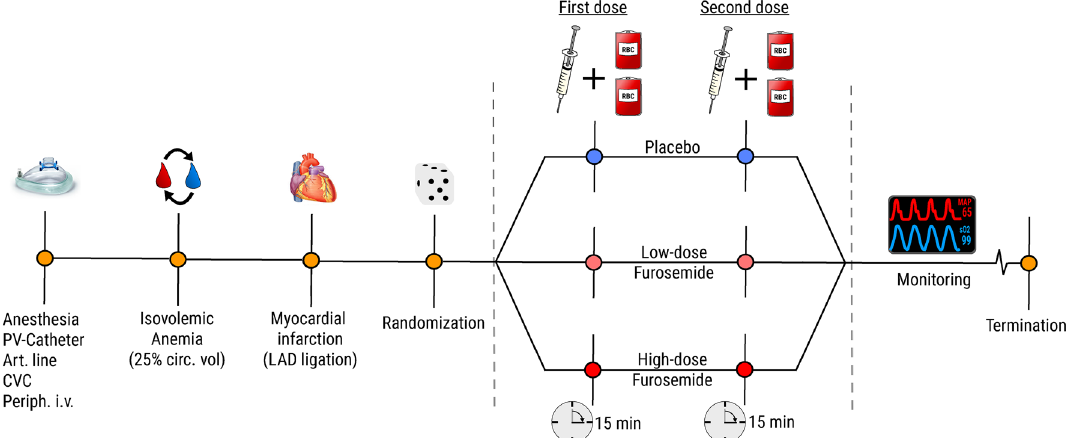
Figure 3. Experimental design. Rats under general anesthesia are made anemic. The first-hit is a myocardial infarction rendering rats volume incompliant. Randomization to placebo, low or high-dose furosemide is performed and prior to transfusion half of the product is administered. Subsequently two RBC units (2.0 mL) are transfused followed by a subsequent dose and transfusion of the remaining two units (2.0 mL). Rats